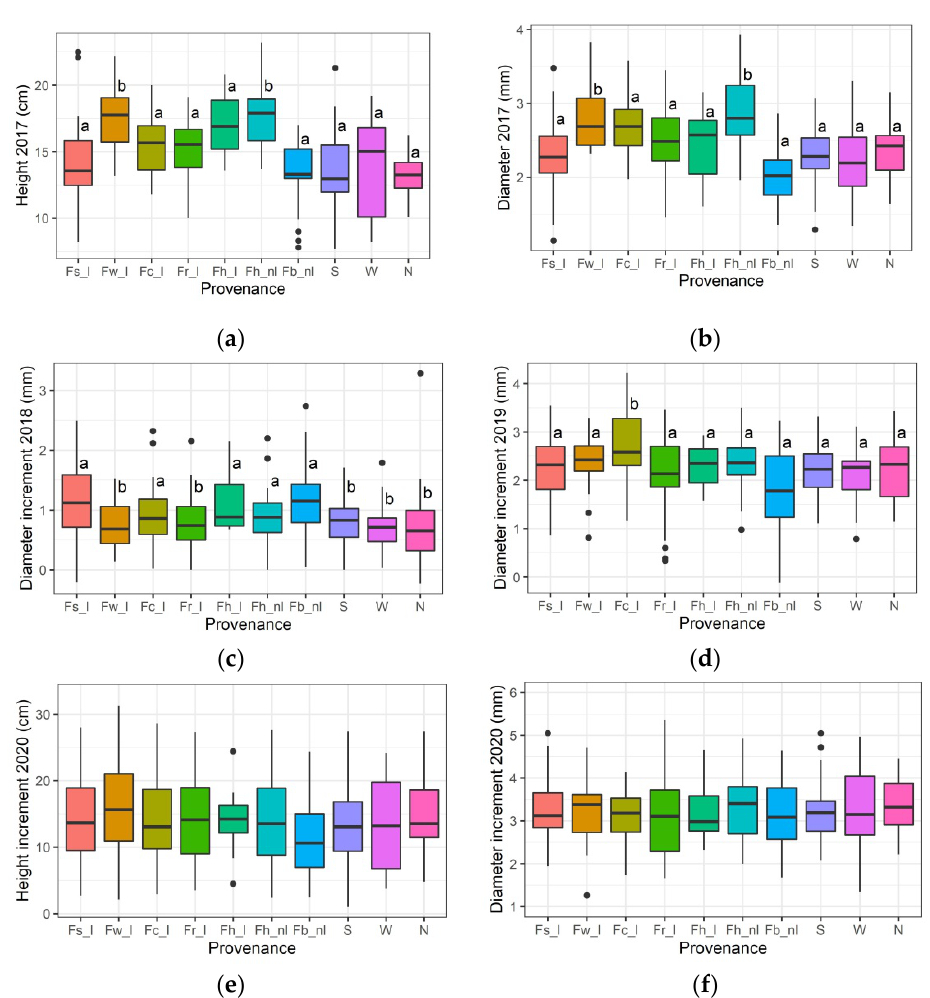
Figure 10. Box plots displaying the height ( a ) and diameter ( b ) of the plants in 2017, the diameter increment in 2018 ( c ) and 2019 ( d ), and the height increment ( e ) and diameter increment ( f ) of the plants in 2020, for the different provenances in the common garden. Any provenance differing significantly from Sonian (“a”), which is the standard provenance in the modelling to which the other provenances are compared, is given a letter “b”. Provenances that do not differ significantly are also given an “a”. Abbreviations of provenances are in Table 1.